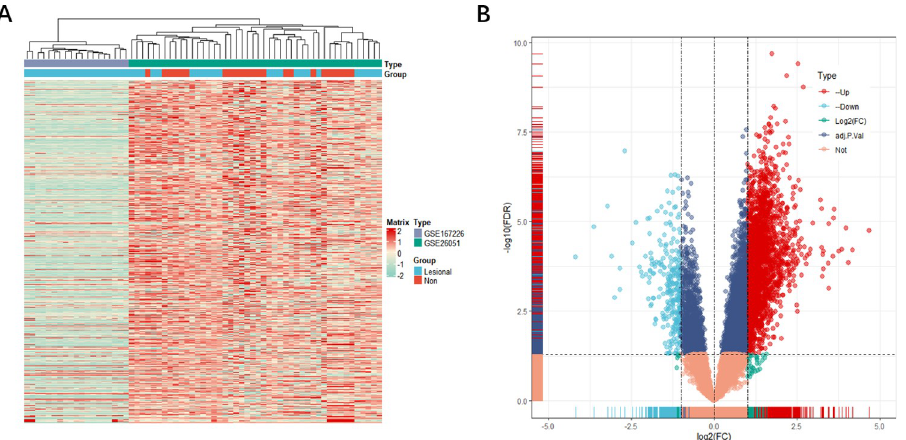
Fig 2. The gene differential expression analysis of GSE26051 and GSE167226 data set. (A) Whole gene expression heat map: Whole gene expression heat map of tendon tissue, with high expression in red and low expression in blue (B) The DEG Volcano map shows upregulated genes in red and down-regulated genes in blue.